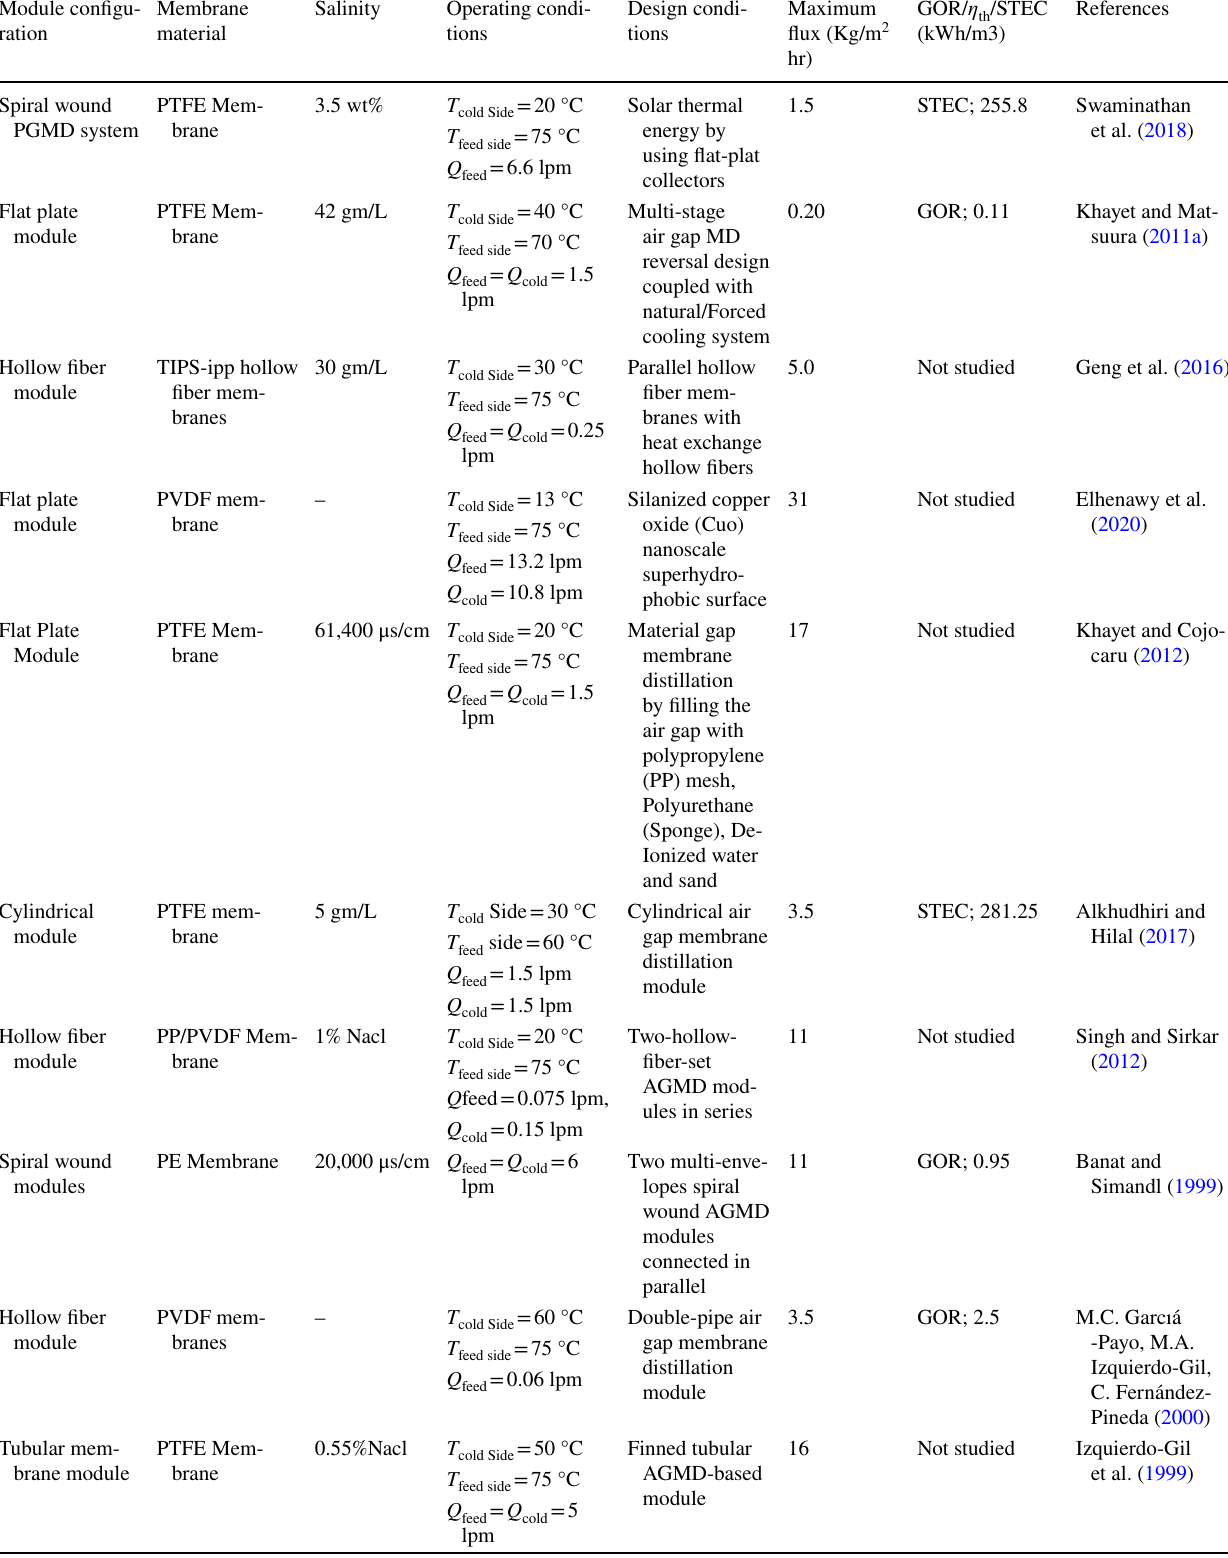
Table 6 Comparison of the system performance for HAGMD and other AGMD modules Module configu-